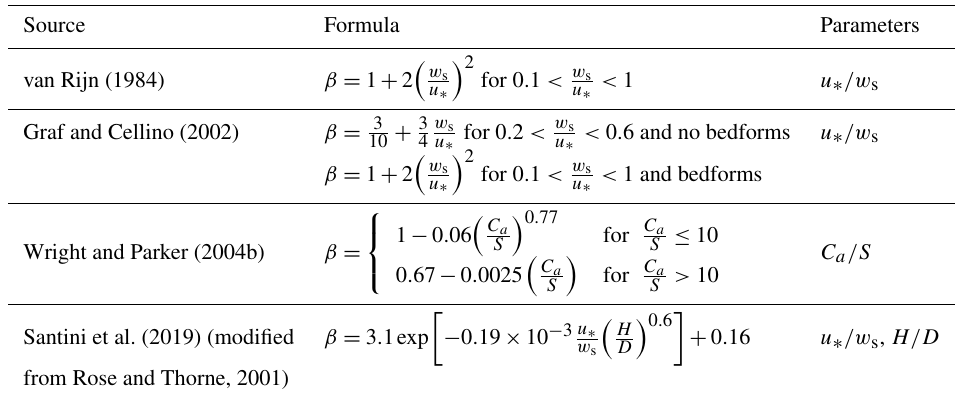
Figure 3. Existing relations for near-bed suspended sediment concentration under equilibrium conditions (i.e., E s = C a ) at the reference level, z = a , specified by each study as a function of (a) grain size and (b) bed stress. In panels (c) and (d) the predicted concentrations are interpolated to a common reference level, a = 0 . 05 H , using the Rouse equation with β = 1 to better compare models. Table 1. Previous relations for the factor β